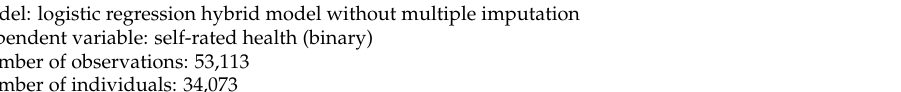
Table 4. Results of the hybrid model without multiple